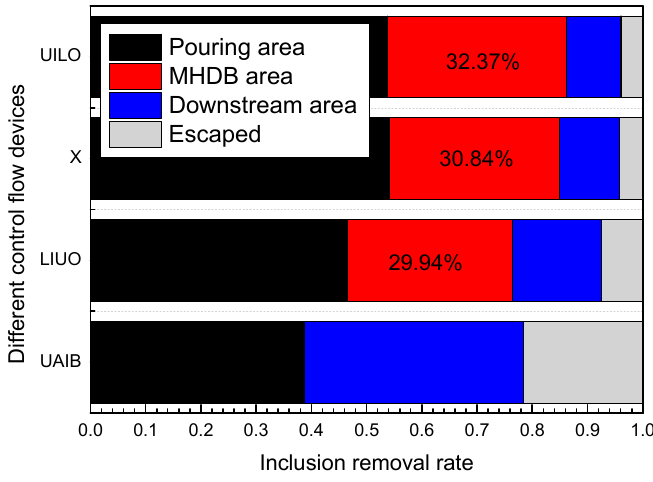
Figure 15. Inclusion removal ratio in tundishes with different control flow devices.